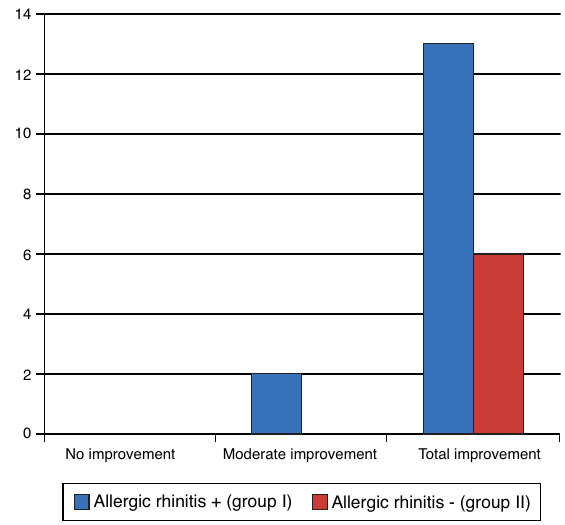
Figure 10 Degree of olfaction